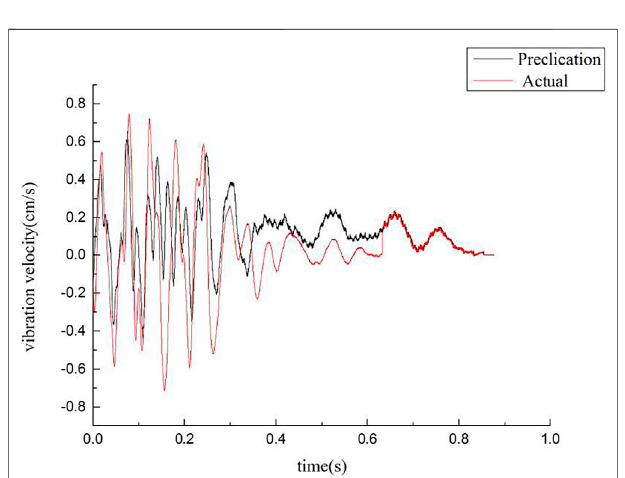
FIGURE 4 | Simulation and measurement of group-hole blasting vibration waveform at point M2.